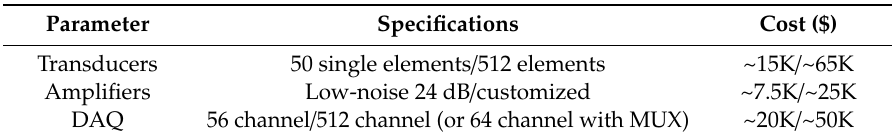
Table 3. Estimated cost of the proposed